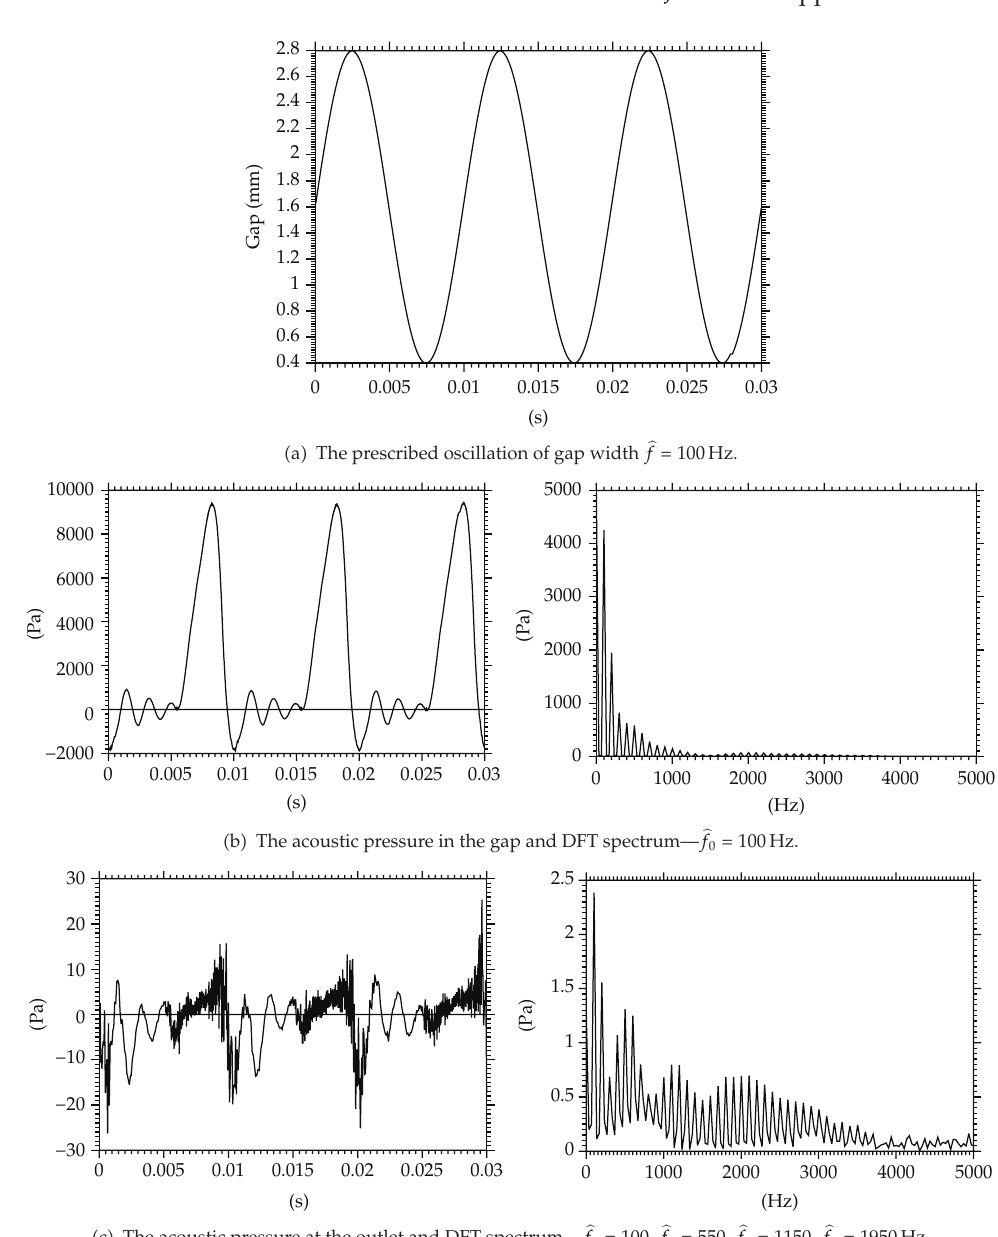
Figure 6: Three vibration periods of the gap width oscillations and the acoustic pressure signals p ac computed in the gap and at the outlet on the axis of the